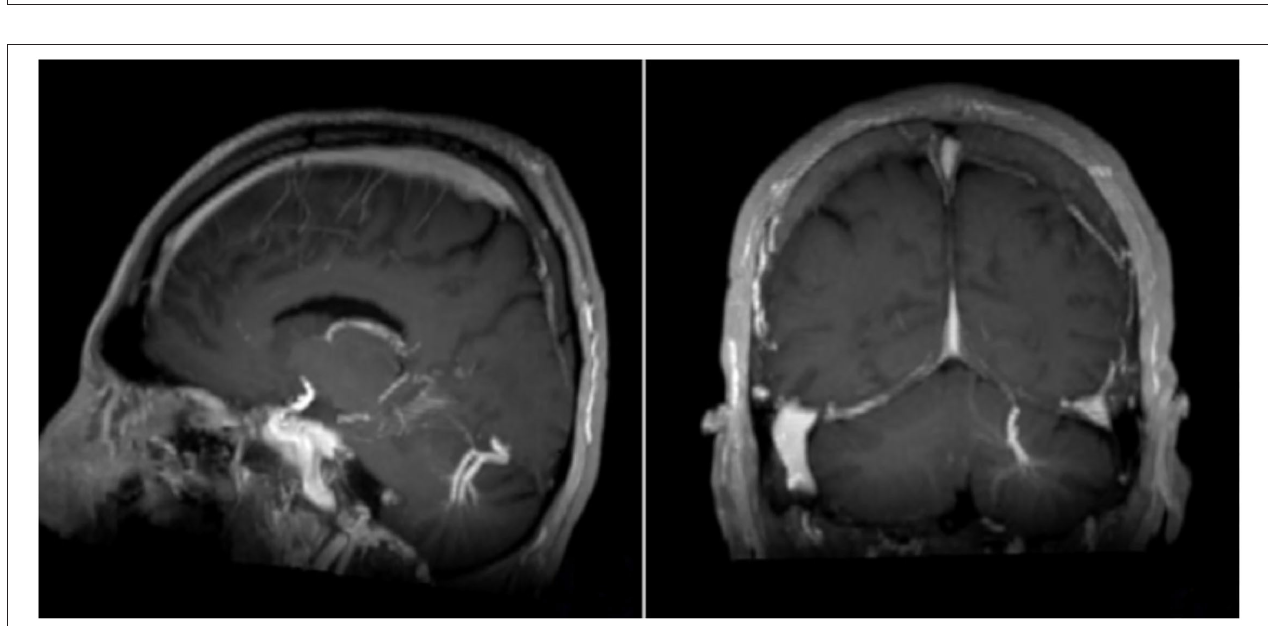
FIGURE 3 | Sagittal and coronar T1-weighted MRI with intravenous contrast medium. Note the big DVA with two collecting veins cerebellar left.